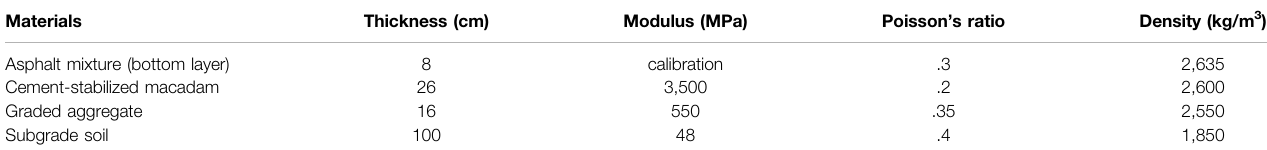
TABLE 2 | Structural and material information for the test pavement.